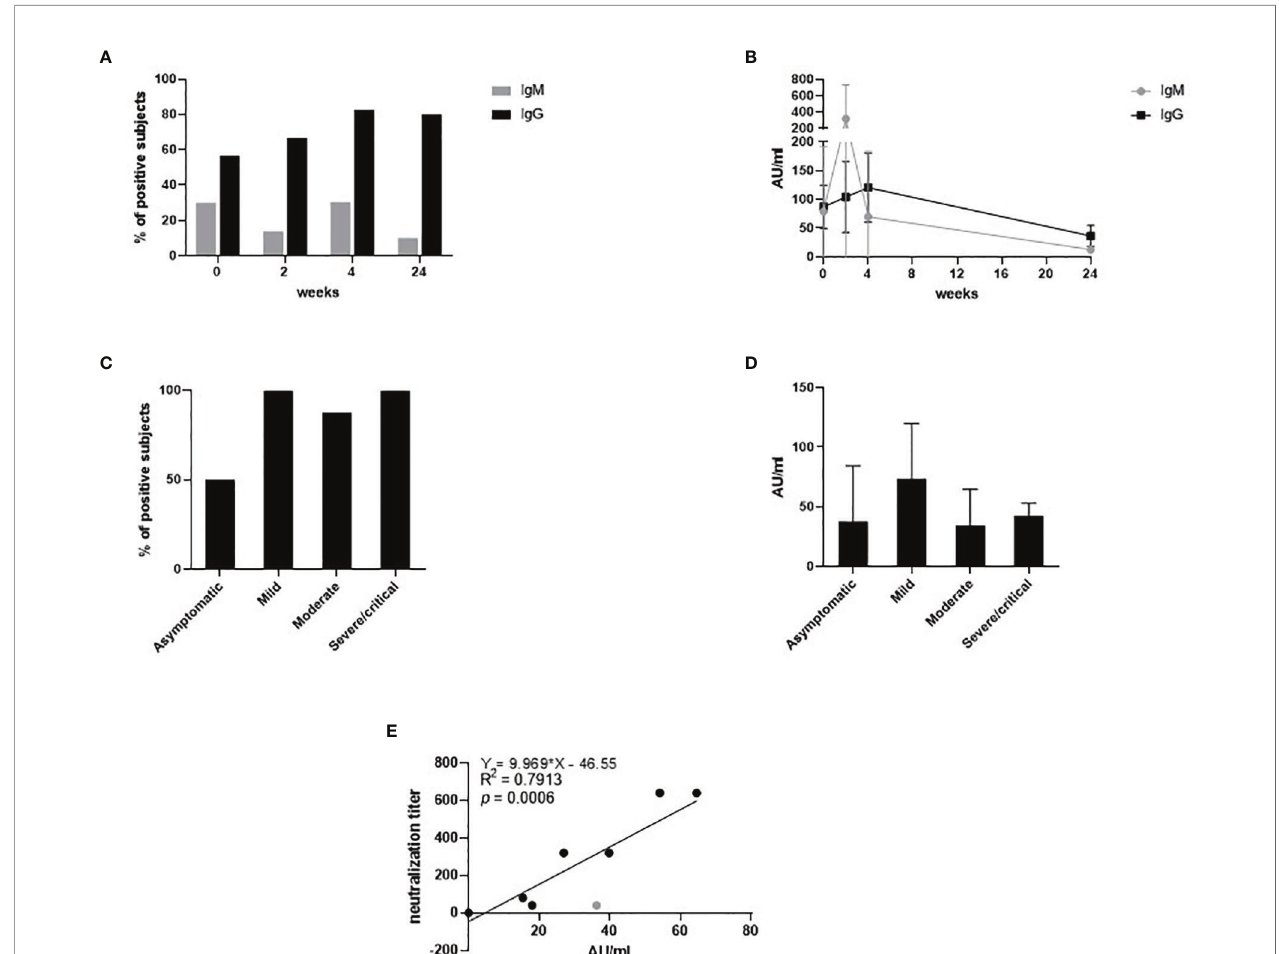
FIGURE 1 | SARS-CoV-2-speci fi c IgM and IgG measured in plasma collected at T0, T2, T4 and T24. The percentage of the positive subjects for IgM (grey) and IgG (black) is depicted throughout the timepoints in (A). The antibody titer expressed in AU/ml for IgM (grey) and IgG (black) is depicted throughout the timepoints in (B) . The percentage of the positive subjects for IgG at T4 strati fi ed by disease severity is depicted in (C) . The antibody titer expressed in AU/ml for IgG at T4 strati fi ed by disease severity is depicted in (D) . The neutralization titer related to the IgG titer expressed in AU/ml is expressed in (E) .